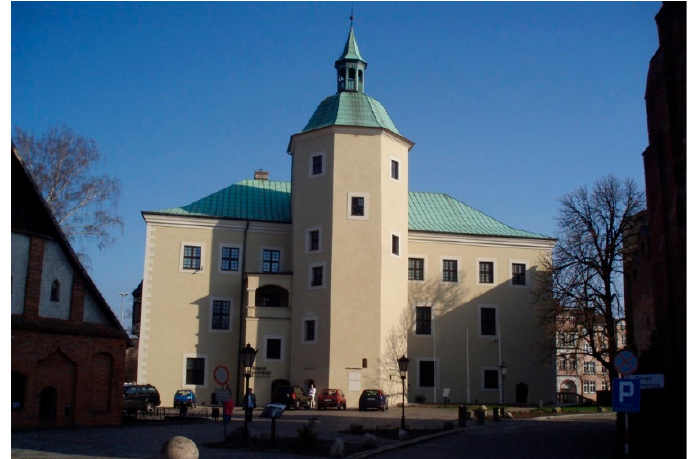
Figure 10. The Pomeranian Dukes’ Castle after the postwar reconstruction, National Heritage Board of Poland, source: Wikimedia Commons.